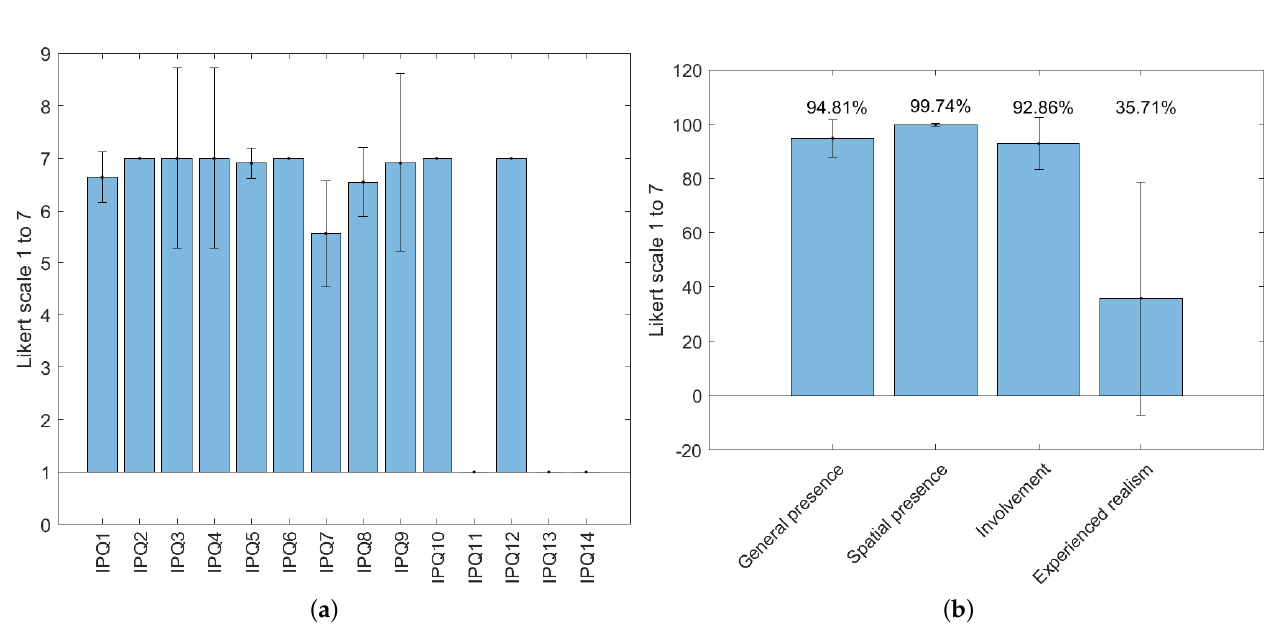
Figure 11. Results of the Igroup presence questionnaire. ( a ) Mean and standard deviation per question. ( b ) Subscales results (mean and standard